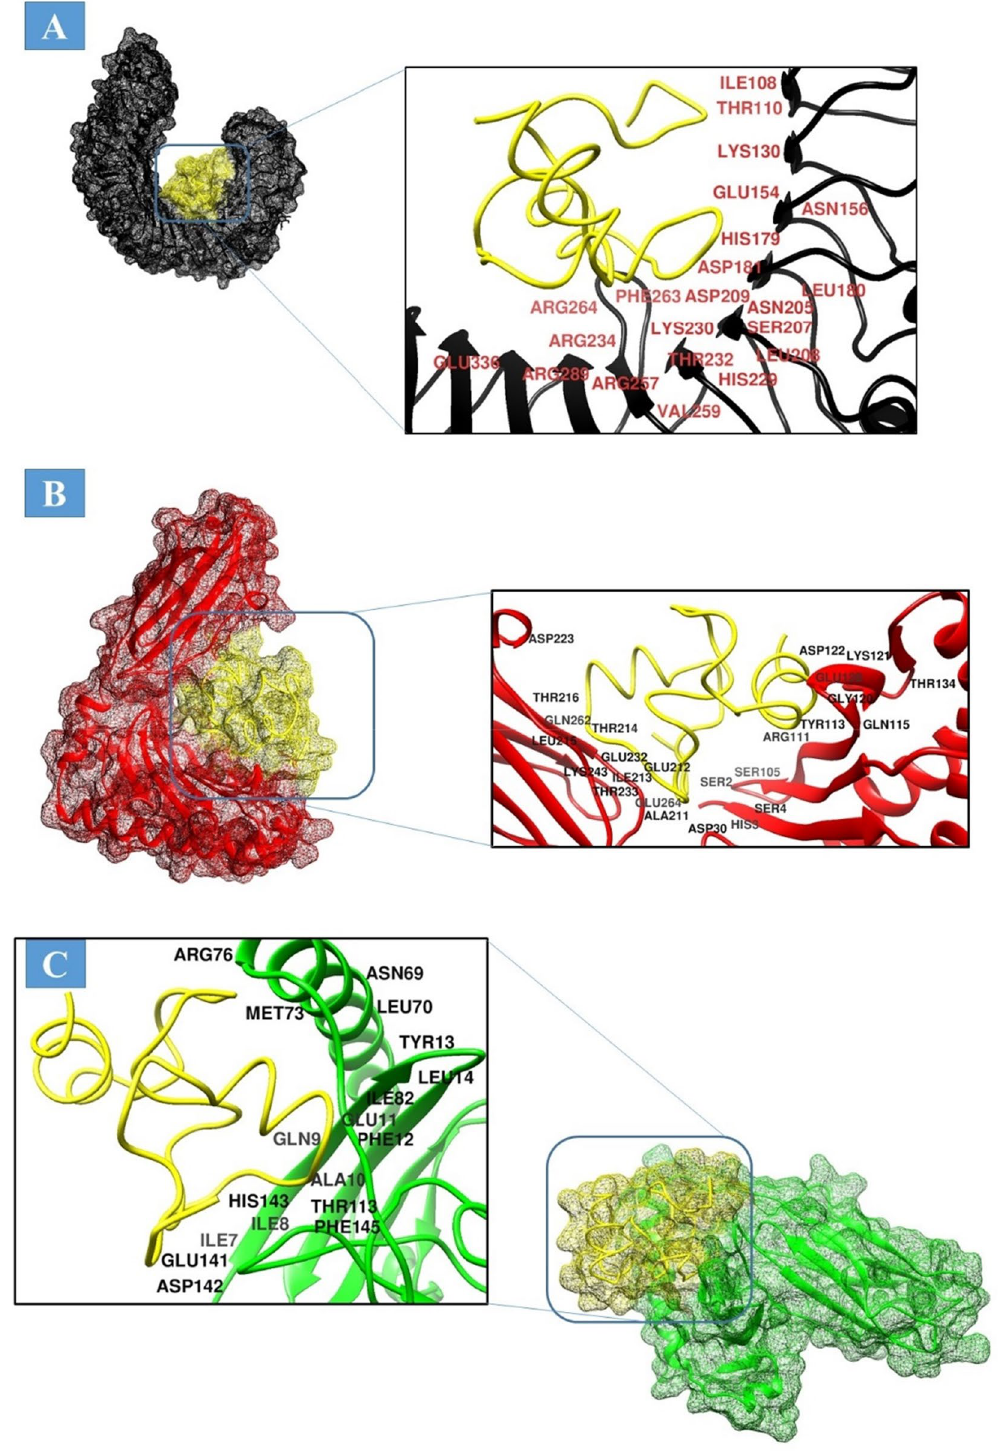
Figure 6. Docked conformation of the designed vaccine to different immune receptors. ( A ) TLR4 (shown in black mesh or cartoon), ( B ) MHC-I (shown in red mesh or cartoon), and ( C ) MHC-II (shown in green mesh or cartoon). The vaccine is presented as yellow mesh and